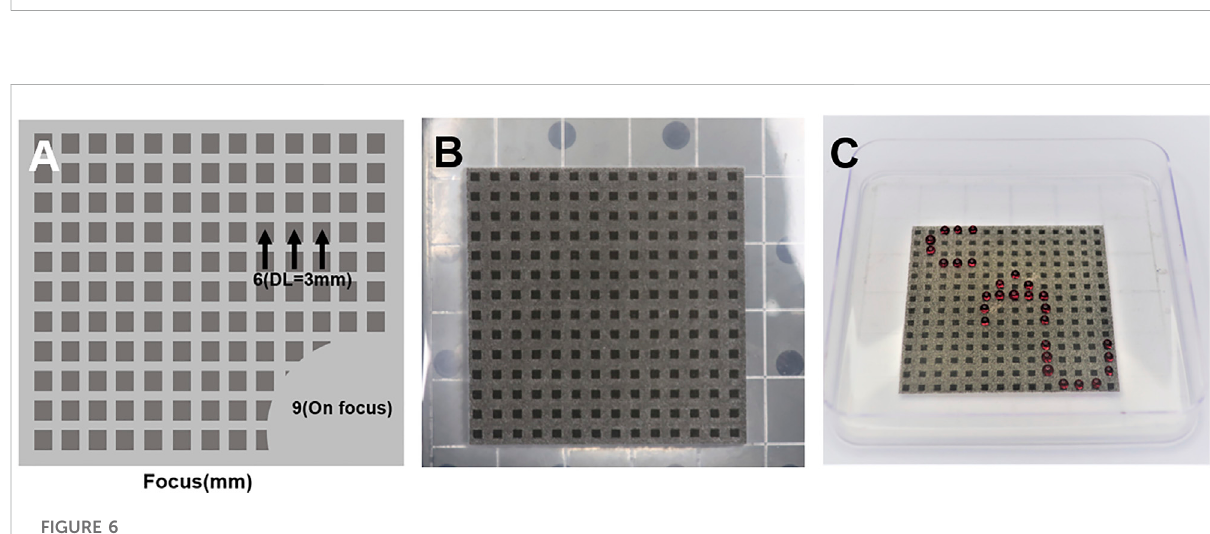
FIGURE 5 Siliconerubbersuperhydrophobicsurfacerecovertest. (A) SuperhydrophobicCAUletters. (B) Waterrepellencyofsuperhydrophobicletters. (C) Scratch off the surface letter C. (D) Laser etching method for in-situ recovery of letter C. (E) Silicone rubber SEM diagram after the destruction of surface structure. (F) SEM image of silicone rubber surface after in-situ recovery. (Scale bar, 20 μ m).